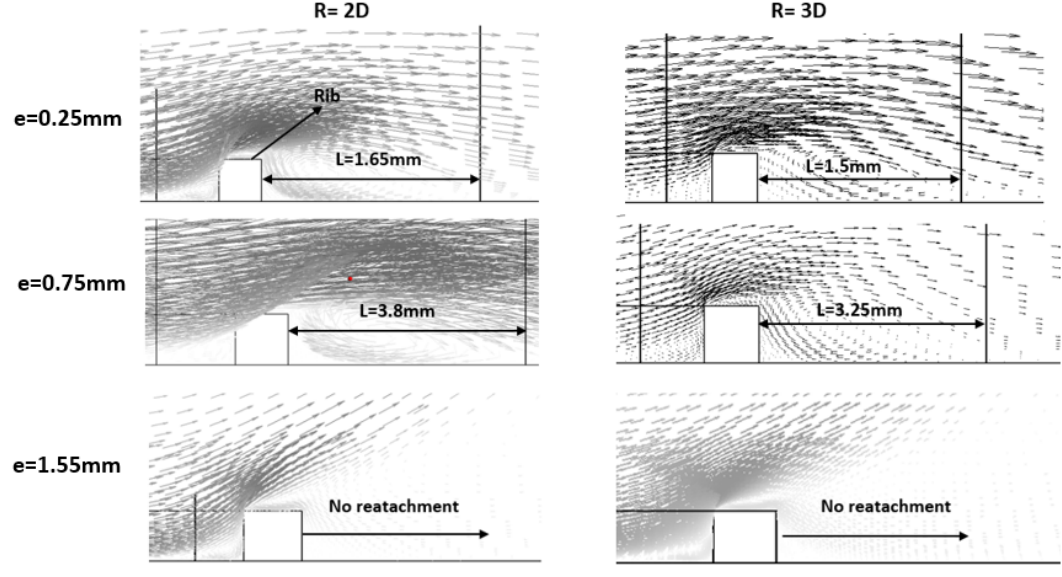
Figure 12. Velocity vector contours for three rib heights at two radial distances.